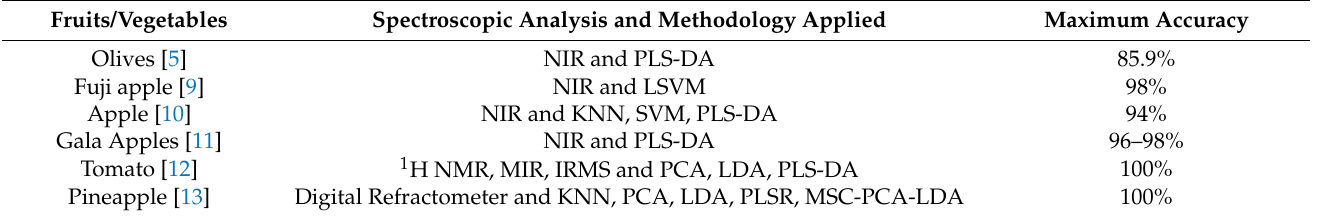
Table 1. Spectroscopic analysis methods for organic and conventional fruits/vegetables discrimination.